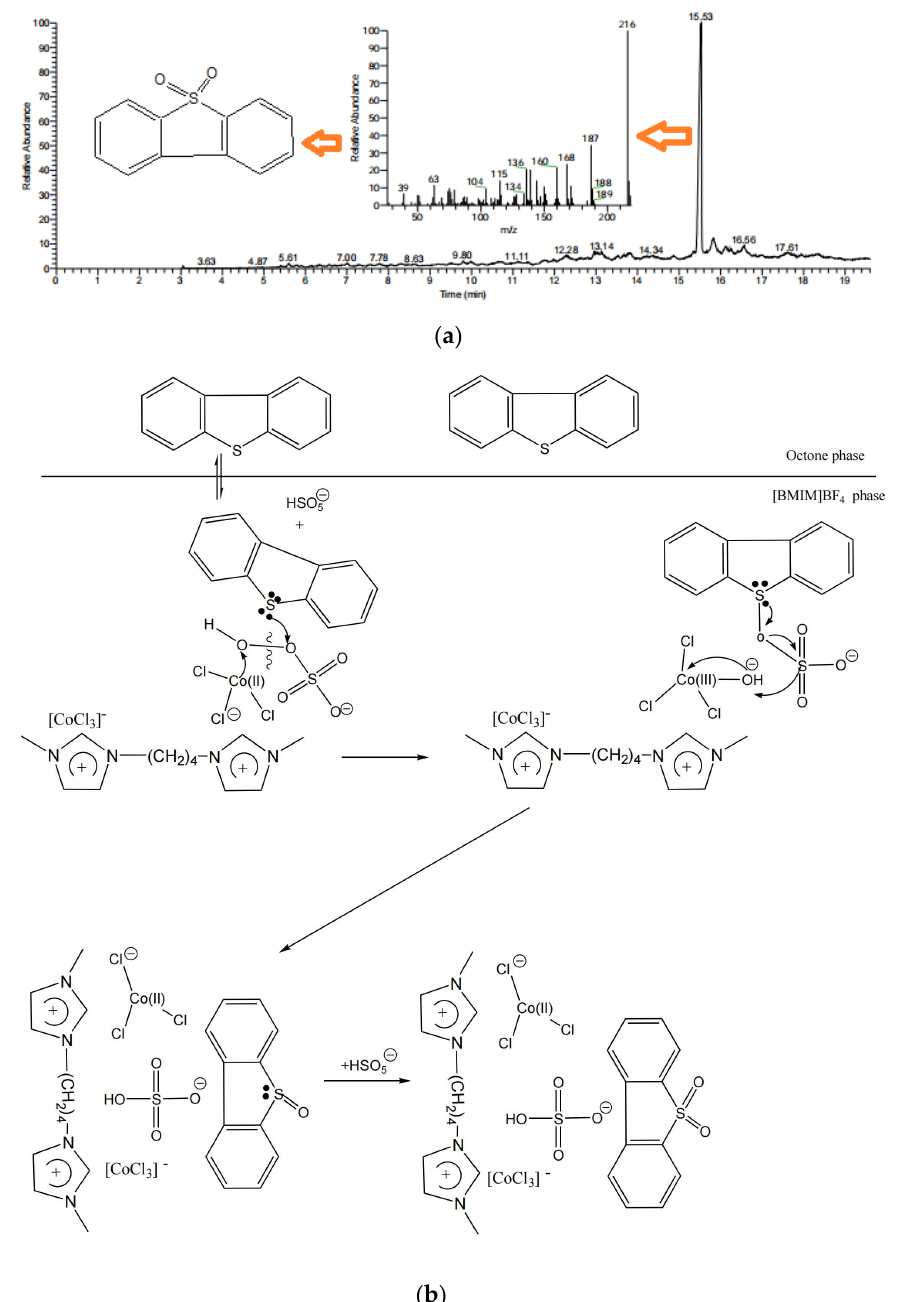
Figure 11. ( a ) GC–MS analysis and ( b ) desulfurization